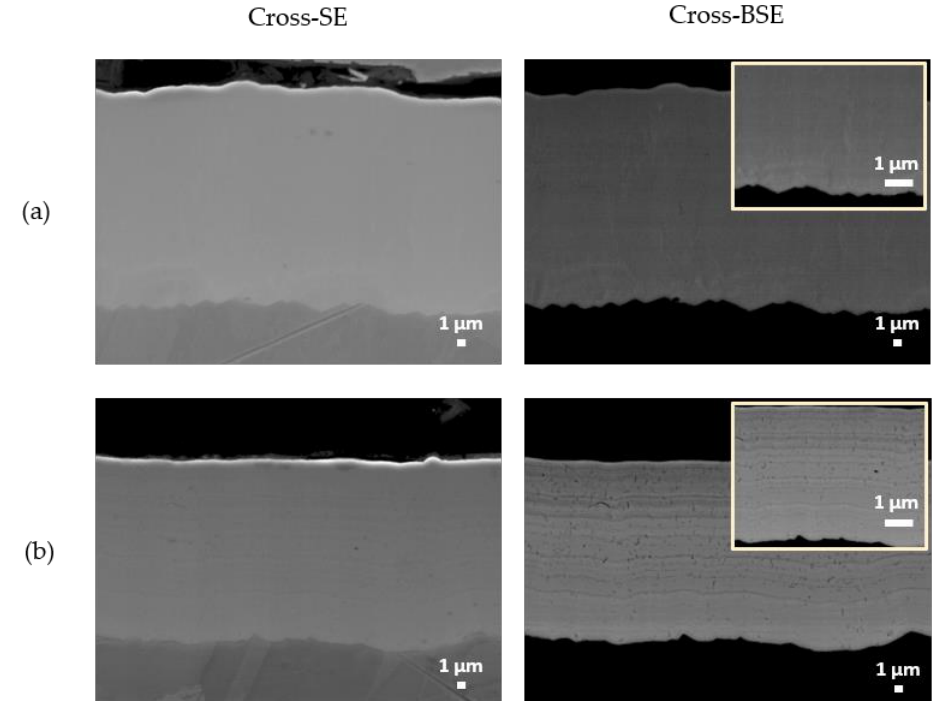
Figure 8. SEM micrographs collected with different detectors, secondary electrons (SE) and backscattered electrons (BSE) in the cross-section of: ( a ) NiSn-P3.3 and ( b ) NiSn-rGO-P3.3.